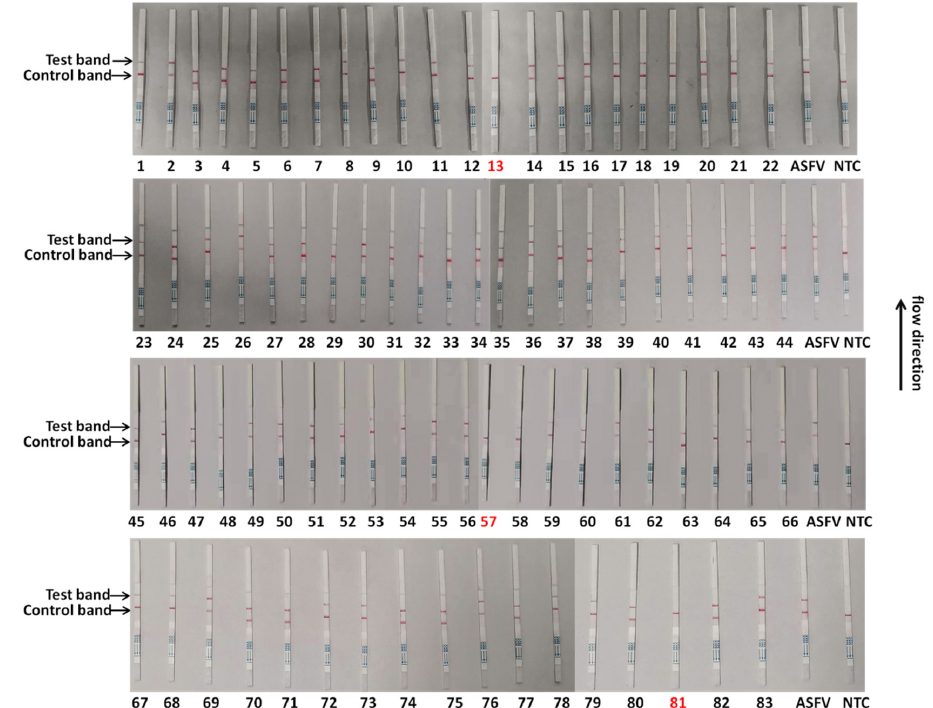
Figure 6. Repeated detection of clinical samples by the CRISPR/Cas13a-LFD. The samples marked with black numbers were ASFV-positive samples, and the samples marked with red numbers were negative. Eighty-three samples were used for